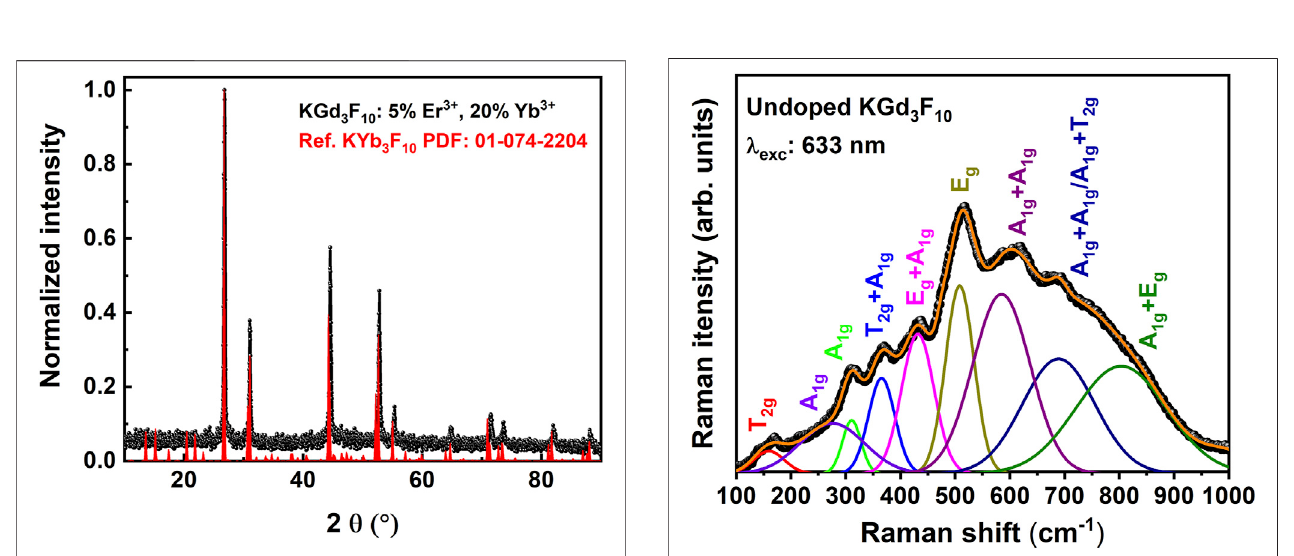
FIGURE 3 | Deconvolution of the Raman spectrum of the undoped KGd 3 F 10 NP powder performed at room temperature under excitation at 633